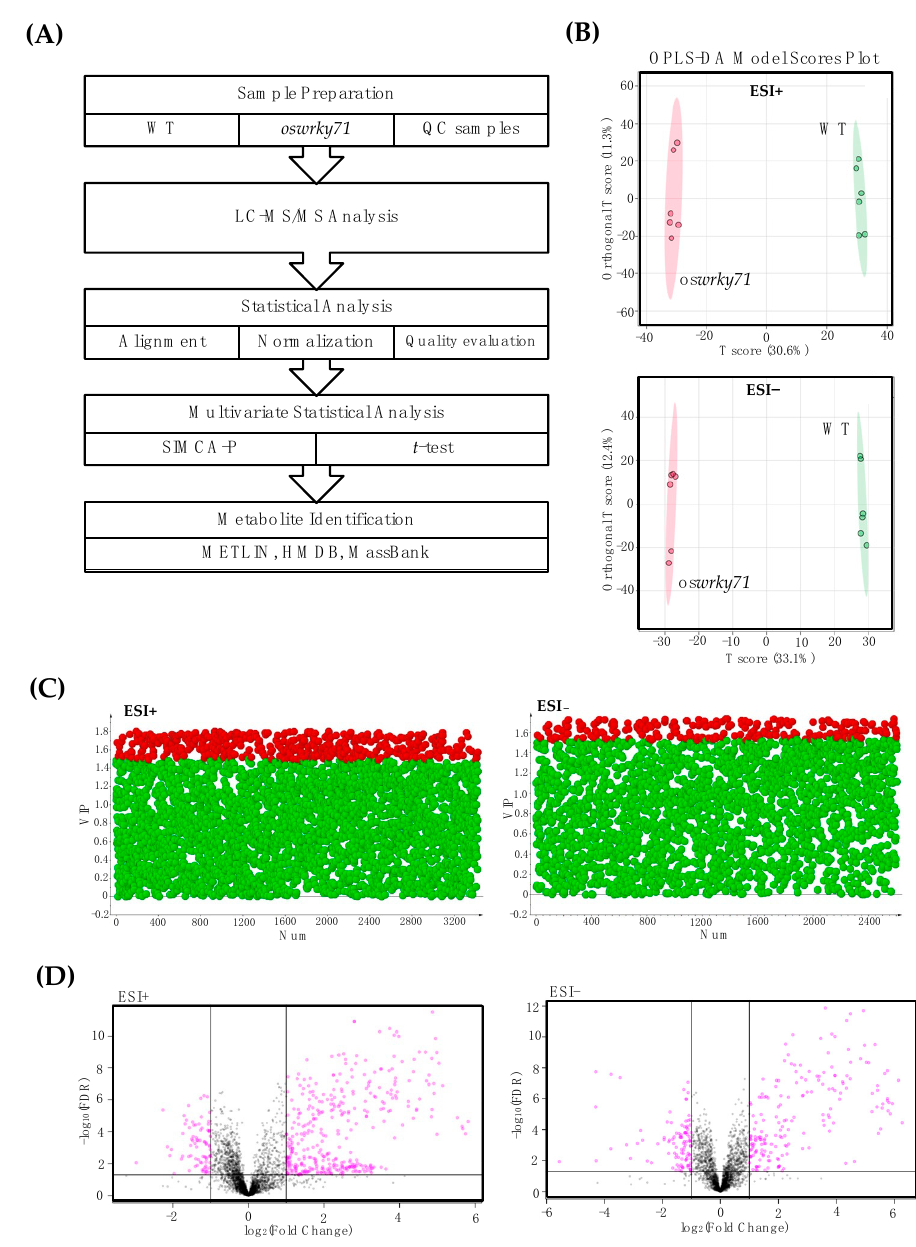
Figure 3. Untargeted metabolomics between WT and oswrky71 threshed grain samples. ( A ) Flowchart showing a pathway for untargeted metabolomics and subsequent bioinformatic analysis. ( B ) Scores scatter plot of the OPLS-DA model in both positive (ESI+) and negative (ESI − ) ion modes. ( C ) Distribution of VIP values (VIP > 1.5) in both positive (ESI+) and negative (ESI − ) ion modes. Red dots indicate significant metabolites. ( D ) Volcano plots of differentially expressed metabolites (purple dots) in oswrky71 threshed grain samples in both positive (ESI+) and negative (ESI − ) ion modes.